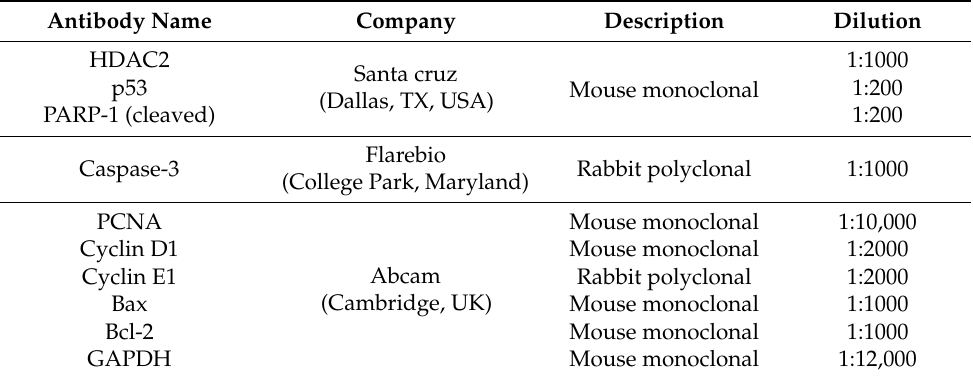
Table 1. Information of antibodies used in this